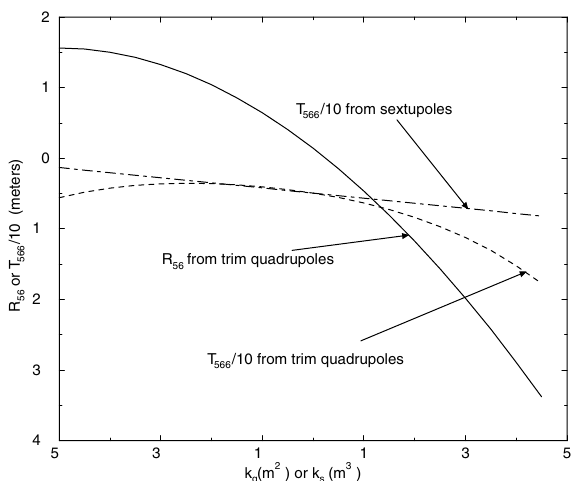
FIG. 5. CTR signal versus SRF-linac phase. The maximum FIG. 4. First ( R ) and second ( T ) order momentum com- CTR signal coincides with the shortest achieved bunch length. 56 566 paction evolutions, for one arc of the recirculator, versus the For the corresponding phase, the longitudinal phase space is settings of the trim quadrupoles and upright.